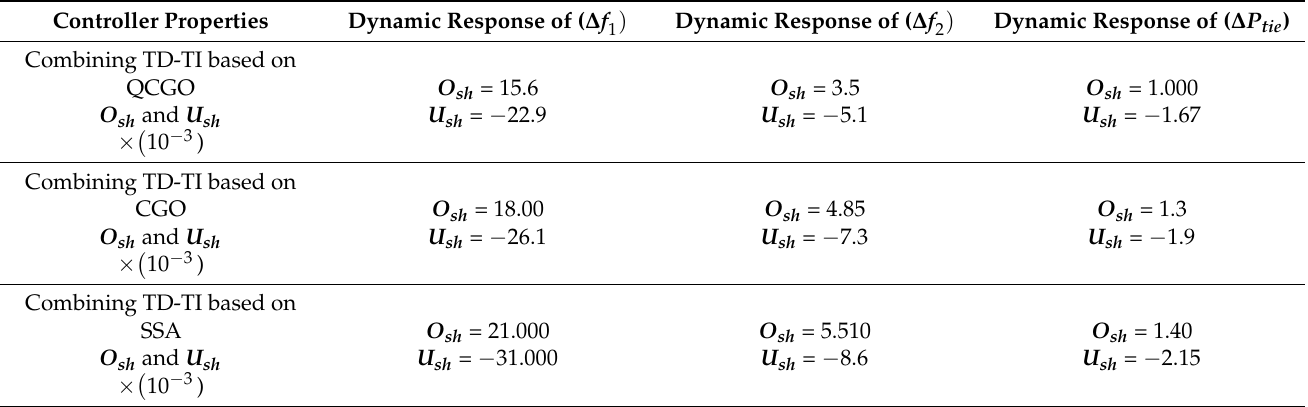
Table 14. The transient response specifications of the presented system for case A.2.